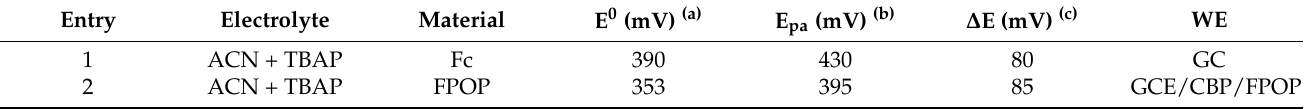
Table 1. Standard potential, anodic peak potential (in mV vs. SCE) and ∆ E p of ferrocene and FPOP modified electrodes in different solvents at 20 ◦